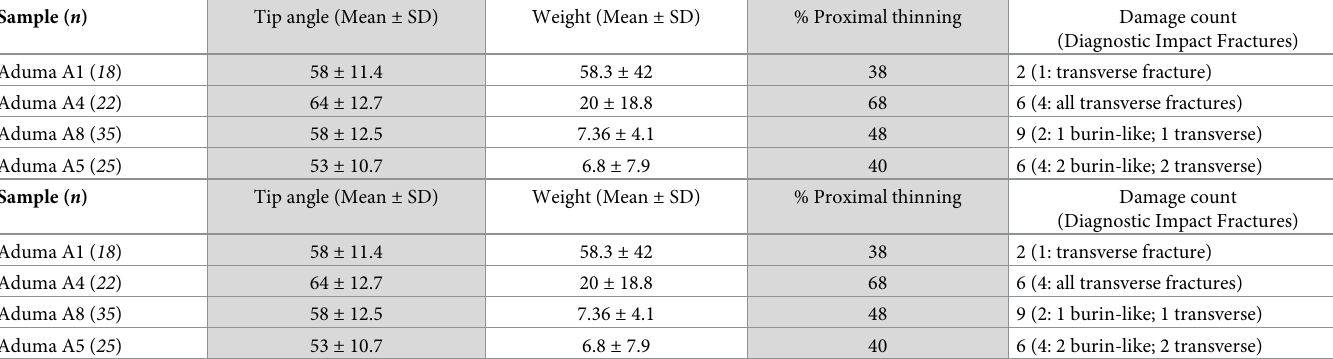
Table 2. Aduma point attributes: tip angle, artifact weight, modification for hafting (through proximal thinning), and damage, including DIFs. Sample ( n )